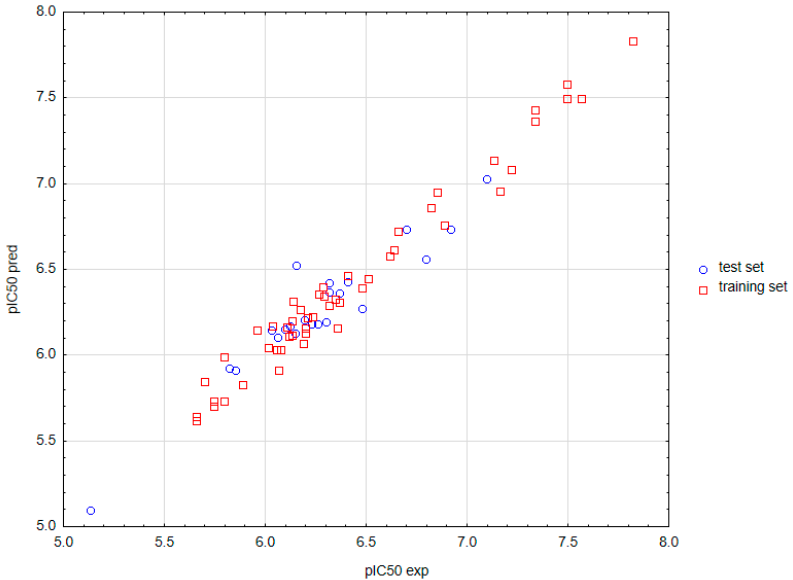
Figure 2. Correlation between the calculated and experimental antitumor data of anthrapyrazoles for the training and test data sets.